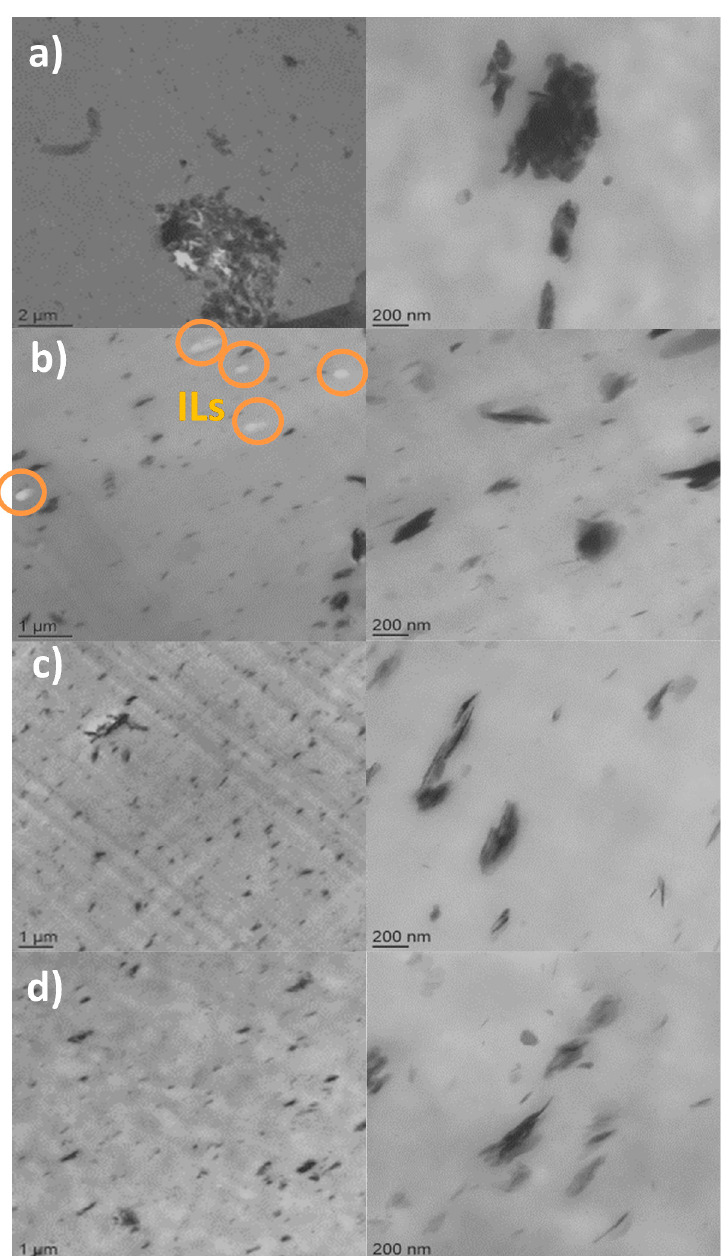
Figure 2. Transmission electron microscopy (TEM) micrographs of poly(butylene adipate- co -terephthalate) (PBAT) nanocomposites with 5 wt % of treated-LDHs: ( a ) PBAT/LDH; ( b ) PBAT/LDH-104; ( c ) PBAT/LDH-351; ( d ) PBAT/LDH-349.